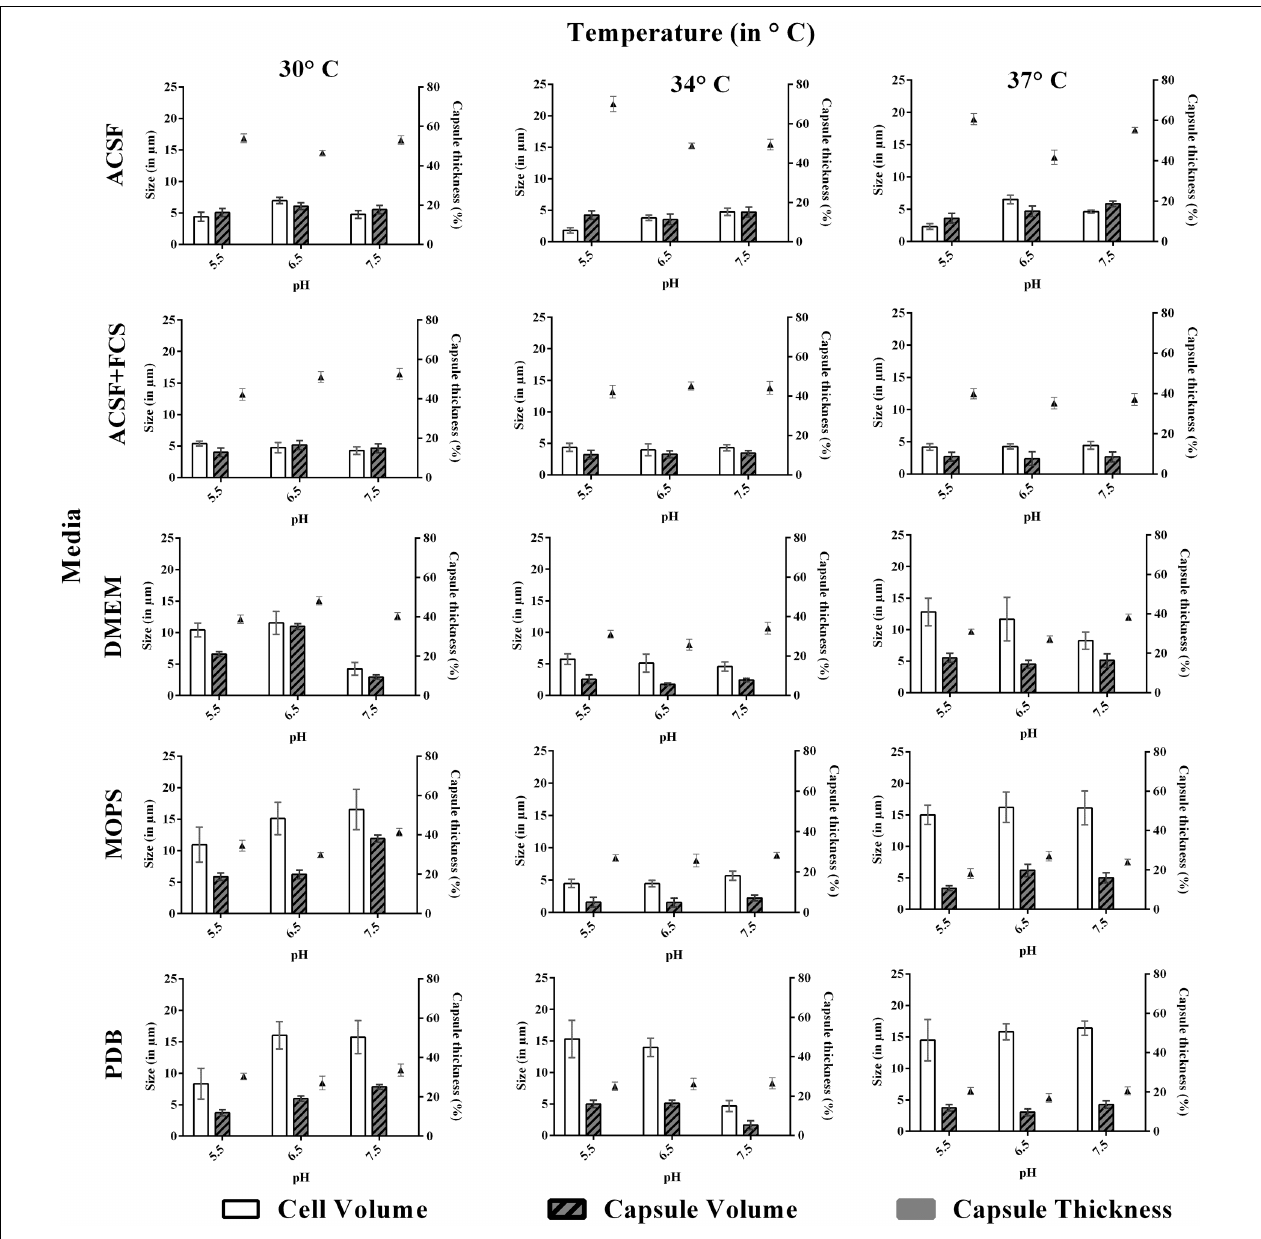
FIGURE 3 | Effect of pH and temperature on capsule induction in ATCC C. neoformans in different media at 72 h. Left Y -axis represents size (in µ m) for cell and capsule, compared with capsule thickness (in %) through right Y -axis. The cell size, capsule size and percentage of the capsule thickness for ≥ 8 cells per group are shown. Bars represent standard errors ( p <